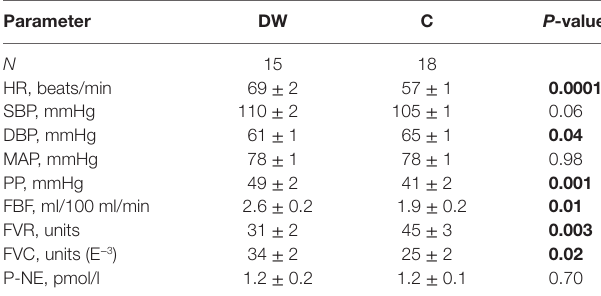
TaBle 2 | cardiovascular parameters in DW and c.